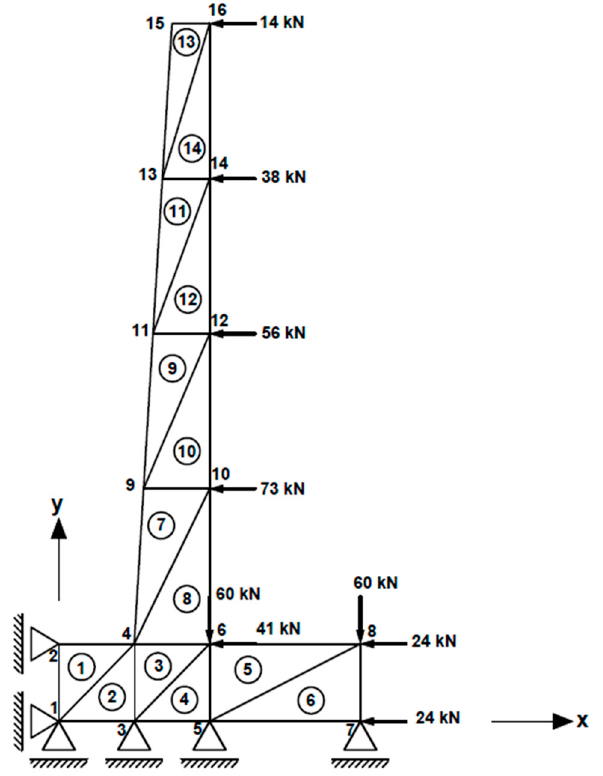
Figure 7. Model for the system with 14 members-16